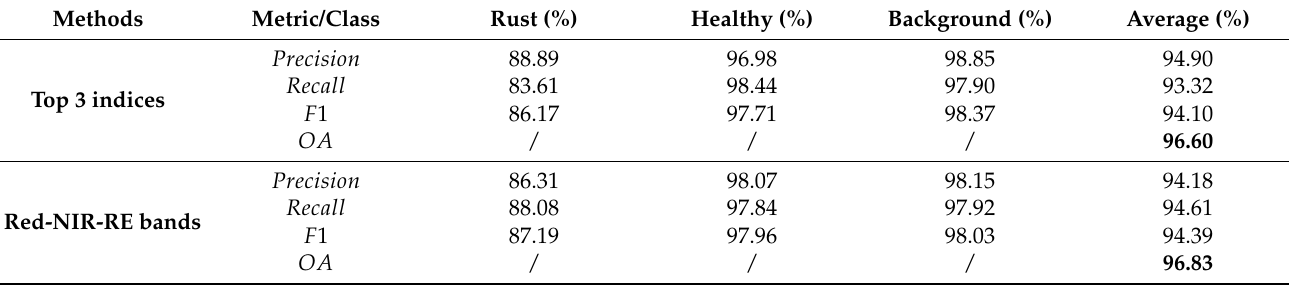
Table 14. Comparison of Red-NIR-RE inputs and the top 3 index